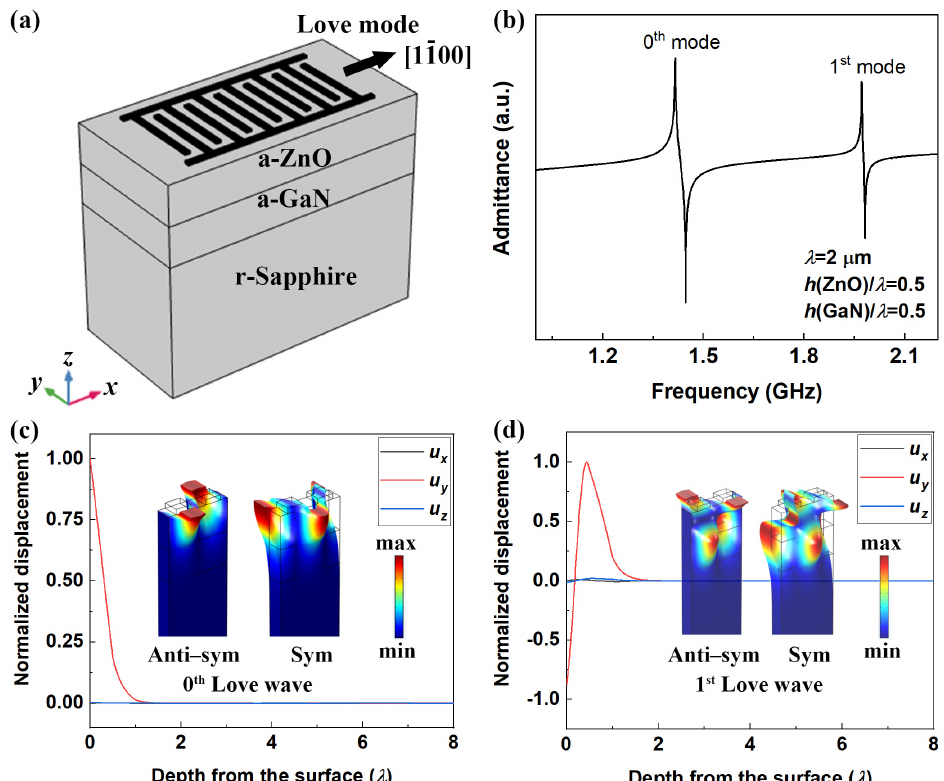
Figure 4. A typical admittance response ( b ) and its corresponding displacement curves and deformation shapes ( c , d ) of the SAW devices based on the a-ZnO/a-GaN/r-sapphire structure ( a ) where Love-mode waves are excited. Electronics 2021 , 9 , x FOR PEER REVIEW